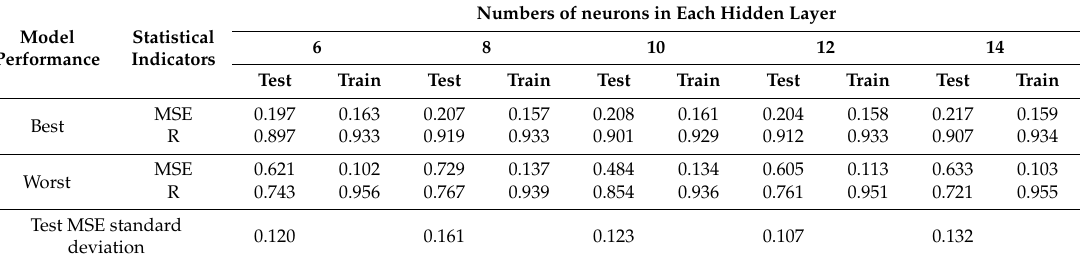
Table 9. E ff ect of data sample variability on the Marshall quotient model’s